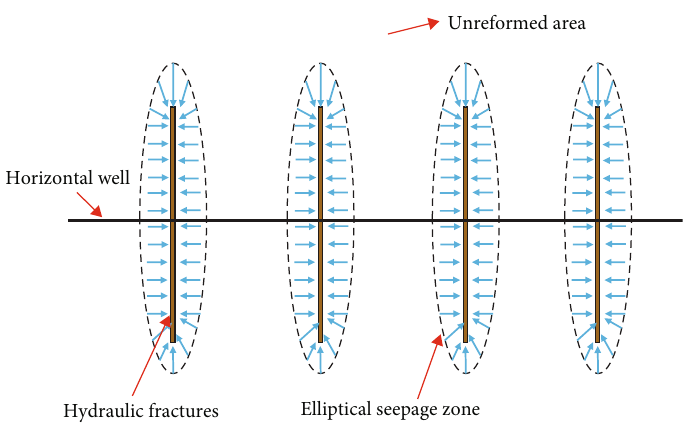
Figure 10: Schematic diagram of the seepage zoning of tight